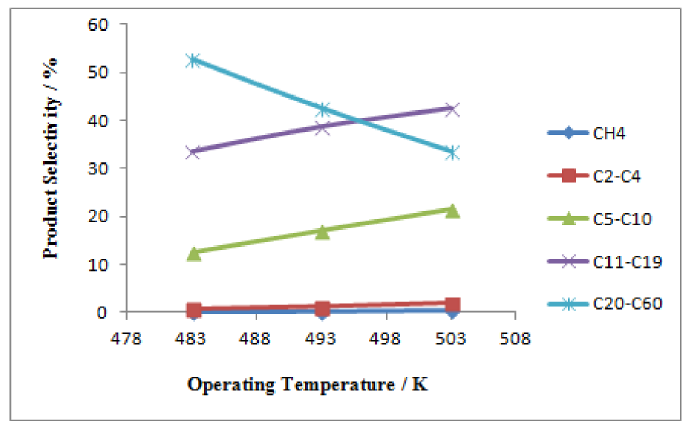
Figure 9. Influence of operating temperature on product selectivity; D t = 0.1 m, H = 2.5 m, V f = 3.5 m 3 /h, P = 20 bar, ε cat =